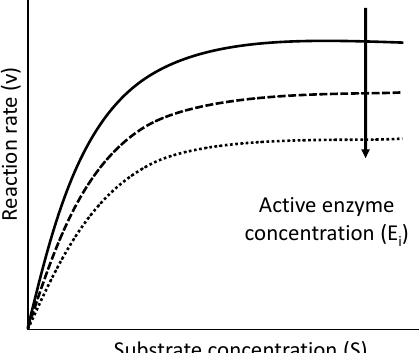
Figure 1. Effect of enzyme deactivation on the reaction rate (v = a). The arrow illustrates the decrease in the active enzyme concentration. The full line is without deactivation, and the dotted lines show the reaction rate when a loss of activity occurs.